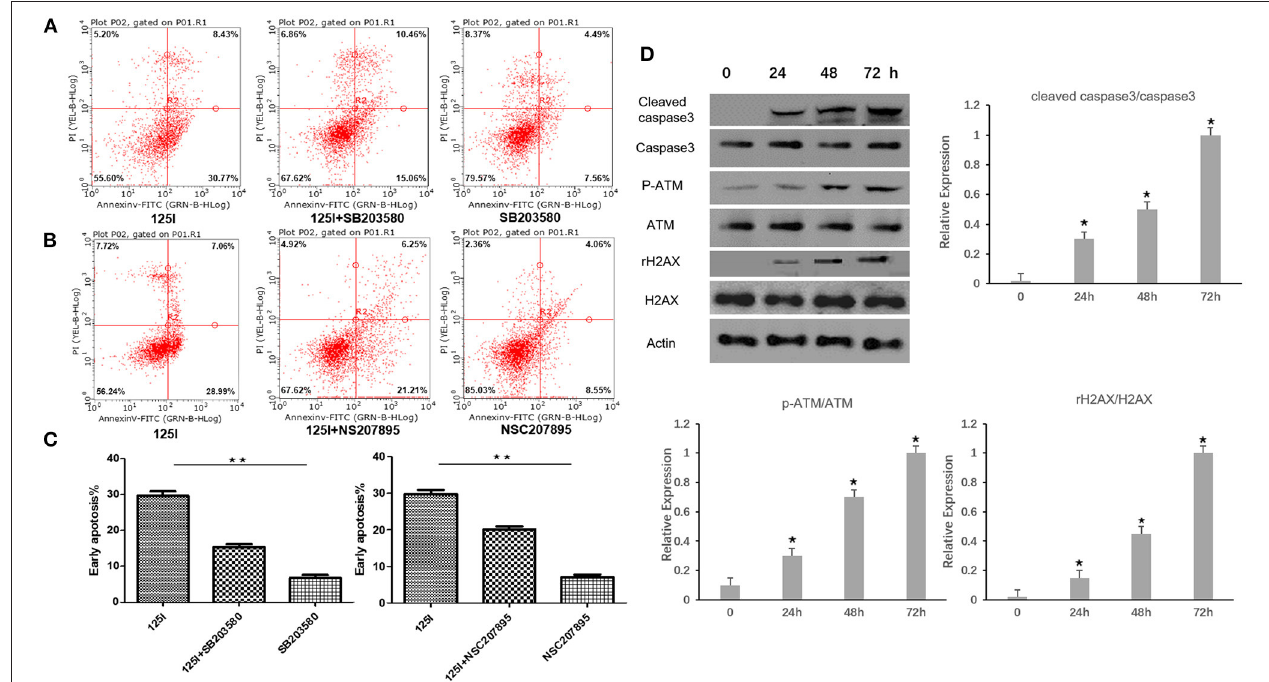
FIGURE 4 | Flow cytometric analysis after treatment of 125 I seed for 72h. (A) The early apoptosis rate of the 125 I seed group (left), the 125 I + SB203580 group (middle), and the SB203580 group (right) is 30.77% ± 1.21, 15.06% ± 1.73, and 7.06% ± 1.54, respectively; ** P < 0.01. (B) The early apoptosis rate of the 125 I seed group (left),the 125 I + NSC207895 group (middle), the NSC207895 group (right) is 28.99% ± 1.15, 21.21% ± 1.52, and 8.55% ± 1.27, respectively; ** P < 0.01. The data represent the means ± SD of three independent experiments. (C) The difference between each groups is statistically significant (** P < 0.01). (D) The level of cleaved-caspase3, p-ATM, and γ -H2AX increased gradually with the increase of irradiation time. * P < 0.05.